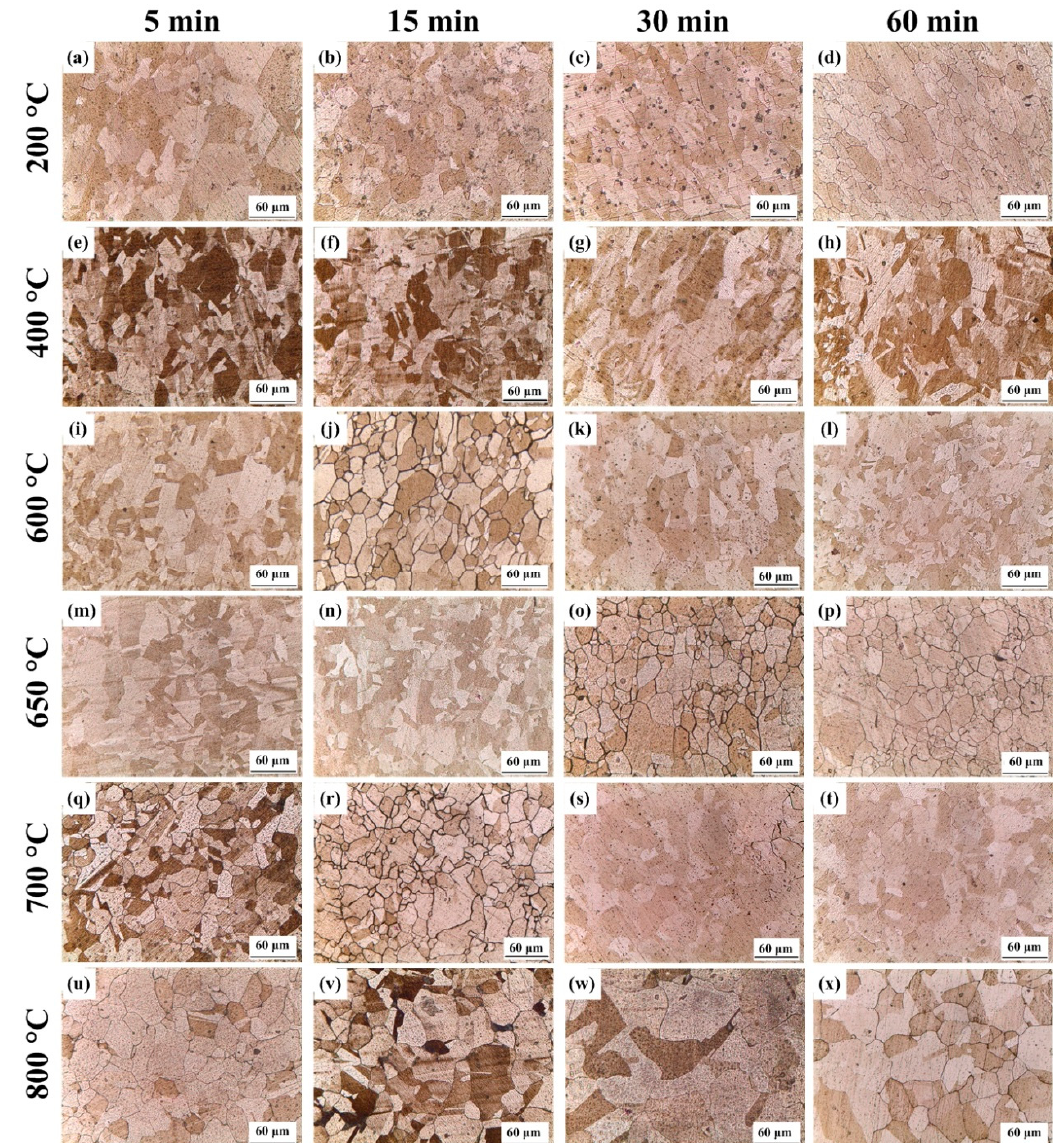
Figure 6. Microstructure of nickel sheets after pass 1 in Scheme 2 with subsequent annealing at different temperatures and time.